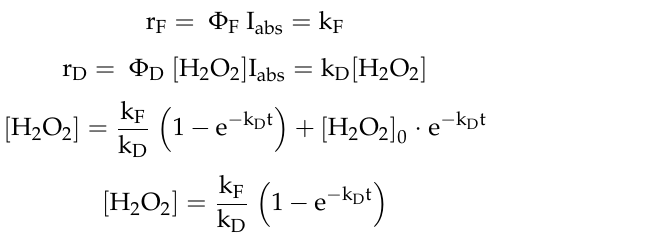
2 O 2 generation on different